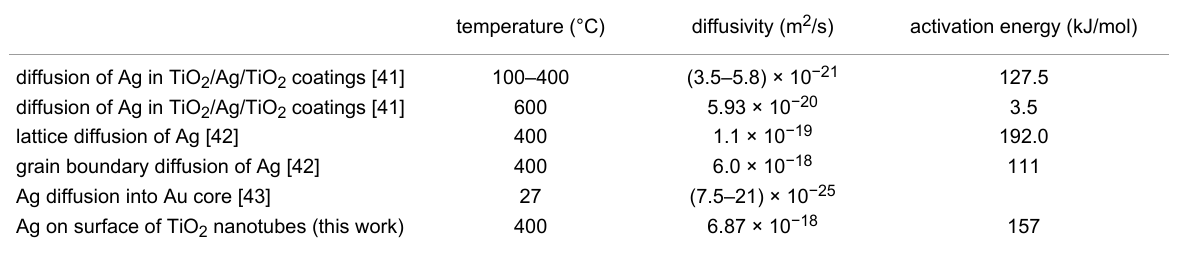
Table 1: Diffusivity and activation energy for the diffusion of Ag.